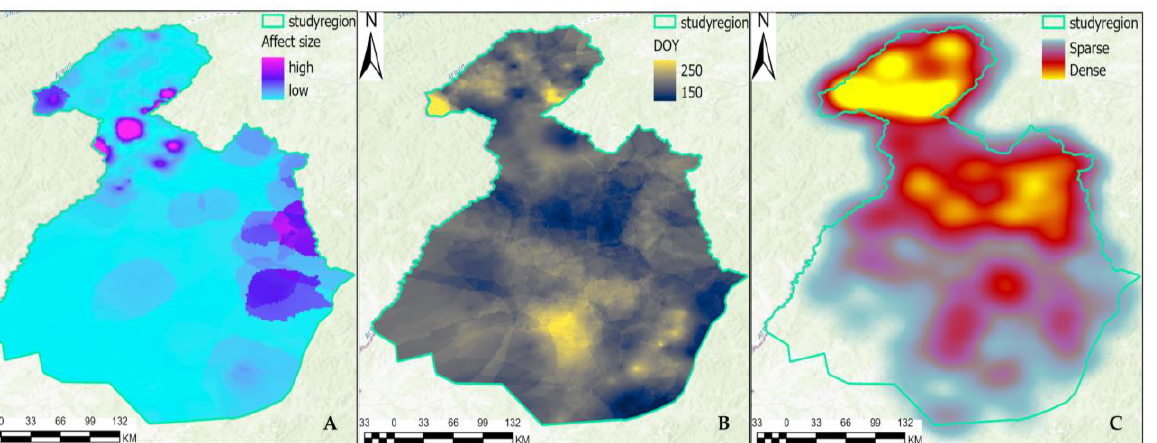
Table 2. Exploring results of fire-affected area.